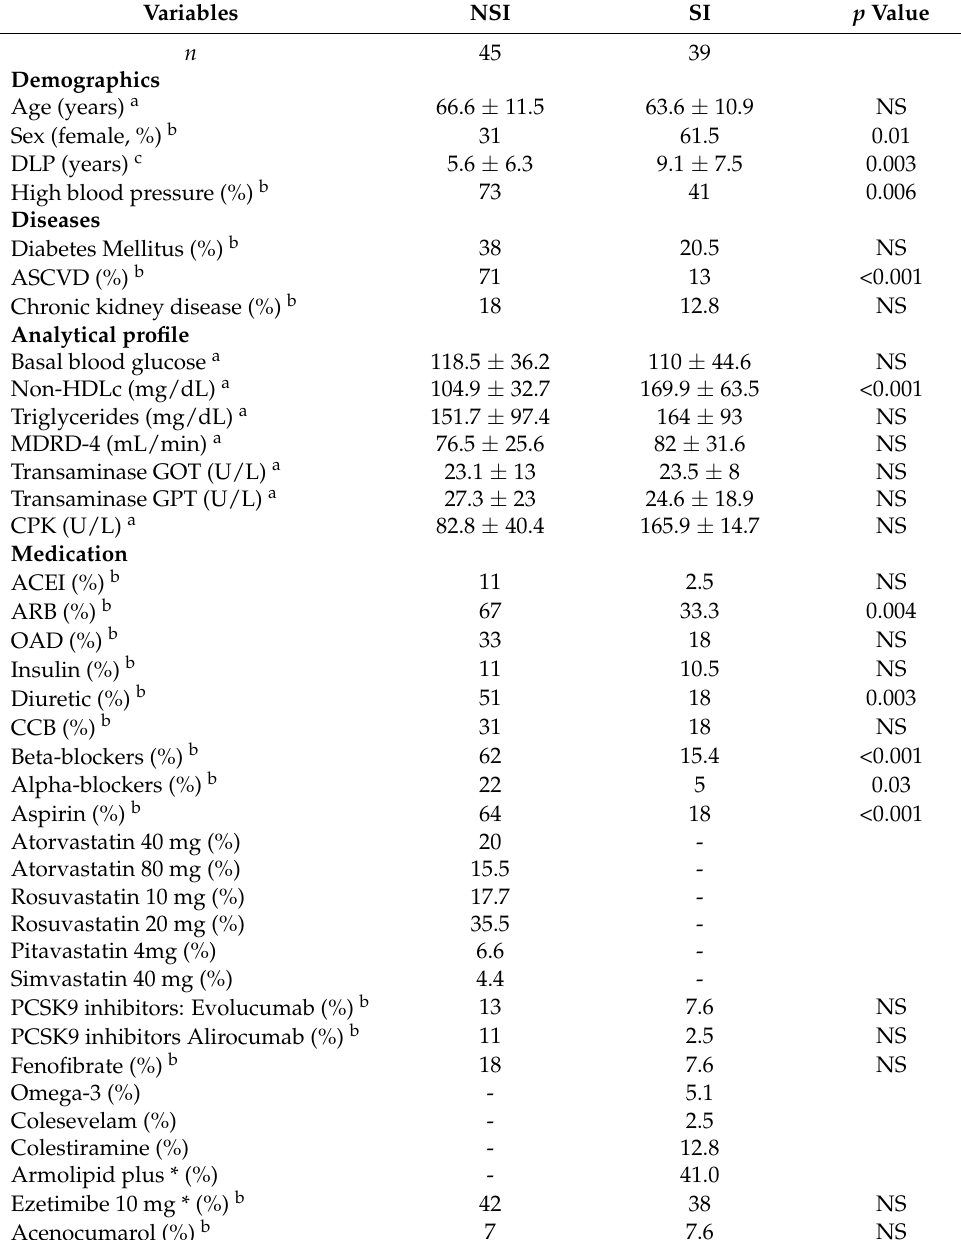
Table 1. Baseline demographics, clinical characteristics, and treatment of NSI and SI population. Data are presented as mean ± SD for continuous variables and as percentage for categorical vari- ables. The difference between NSI and SI patients was evaluated with unpaired Student t test a , Pearson Chi-square b and Wilcoxon test c . * Therapy mostly in association. NS, no significant; ACEI: angiotensin-converting enzyme inhibitors; ARB: angiotensin II receptor blockers; ASCVD: atheroscle- rotic cardiovascular disease; CCB: calcium channel blockers; CPK: creatine kinase; DLP: years of dyslipidemia; MDRD-4: glomerular filtration rates; non-HDLc: non-high-density lipoprotein choles- terol; NSI: non-statin intolerant; OAD: oral antidiabetic drugs; PSCK-9: Monoclonal anti-proprotein convertase subtilisin/kexin type 9; SI: statin